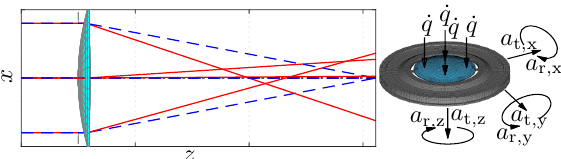
Figure 1. Single Lens optical system with all excitations (right) and the raypaths of the ideal system (blue, dashed) and the dy- namical and thermal excited system